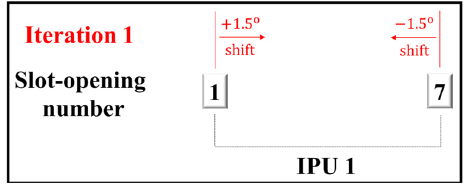
Figure 8. The slot-opening shift angle in an IPU (10P12S).